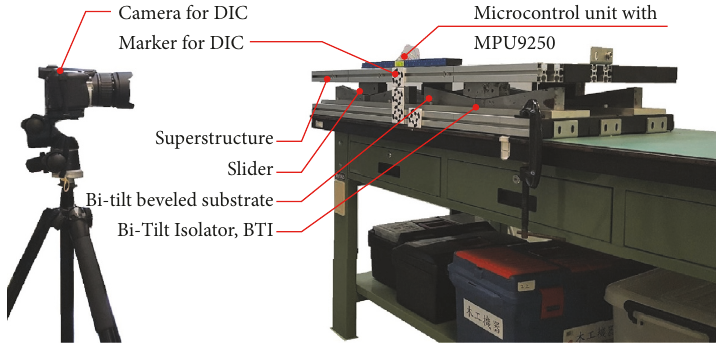
Figure 6: Set-up for experimental design and data